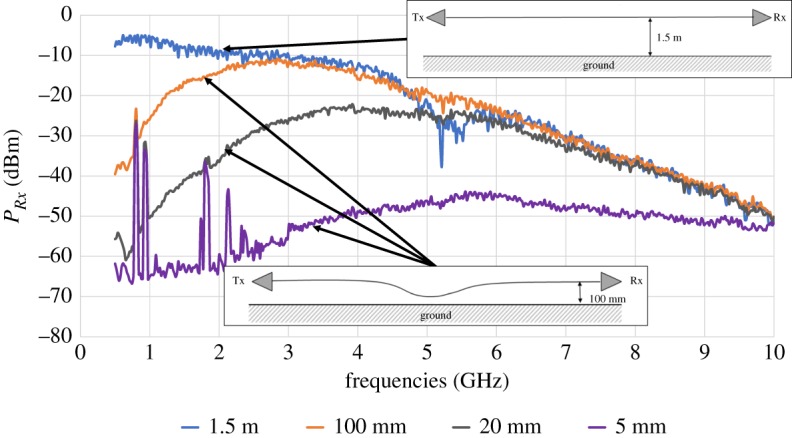
Experimental data of the received power through a 20 m cable suspended 100 mm above ground. The middle of the cable was brought to distances of 100 mm, 20 mm and 5 mm from the ground. A benchmark measurement with the entire cable suspended 1.5 m above the ground is included as well. The insets show schematics of the experimental set-up. When the cable is close to the ground high loss is observed. As the frequency increases behaviour similar to that of the benchmark measurement is recovered. (Online version in colour.)